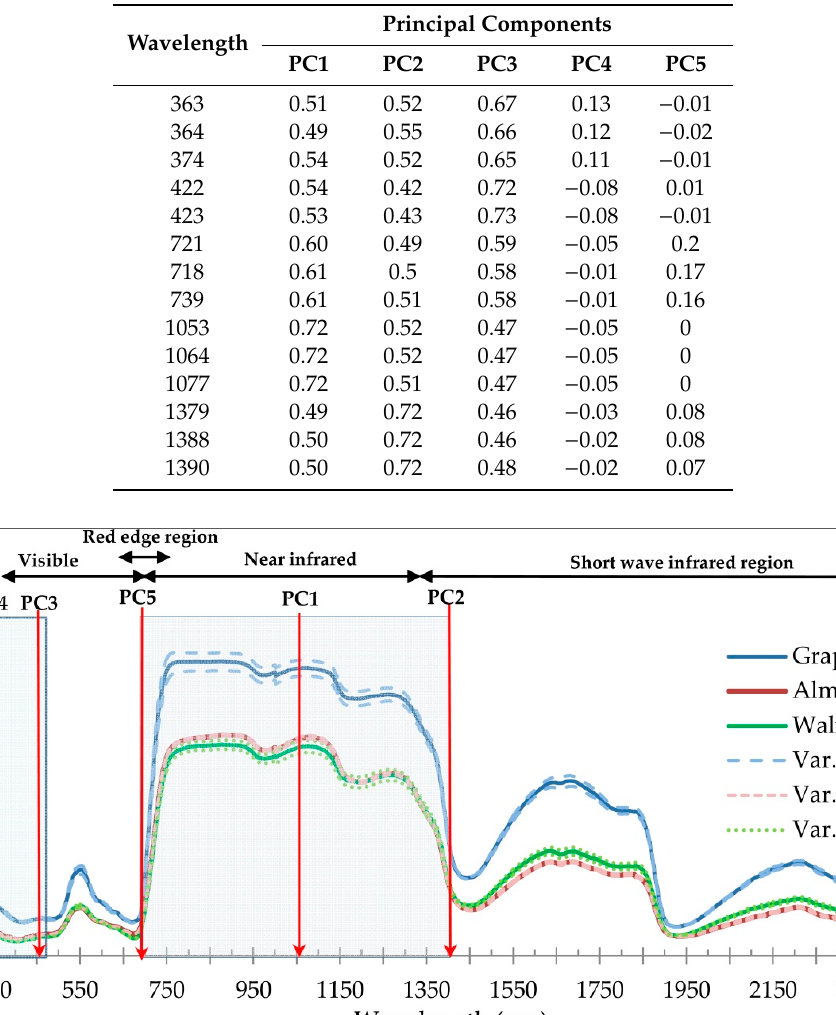
Table 1. Principal component analysis (PCA) results; factor loads of the most important wavelengths in the first five components with Varimax rotation method.